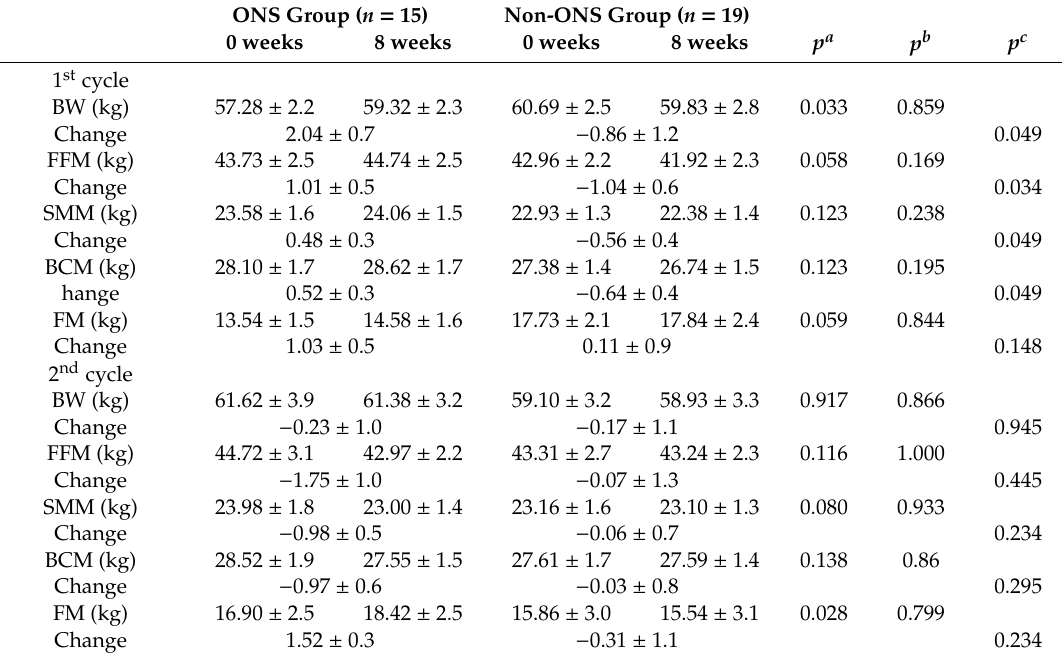
Table 2. Change of body composition by chemotherapy